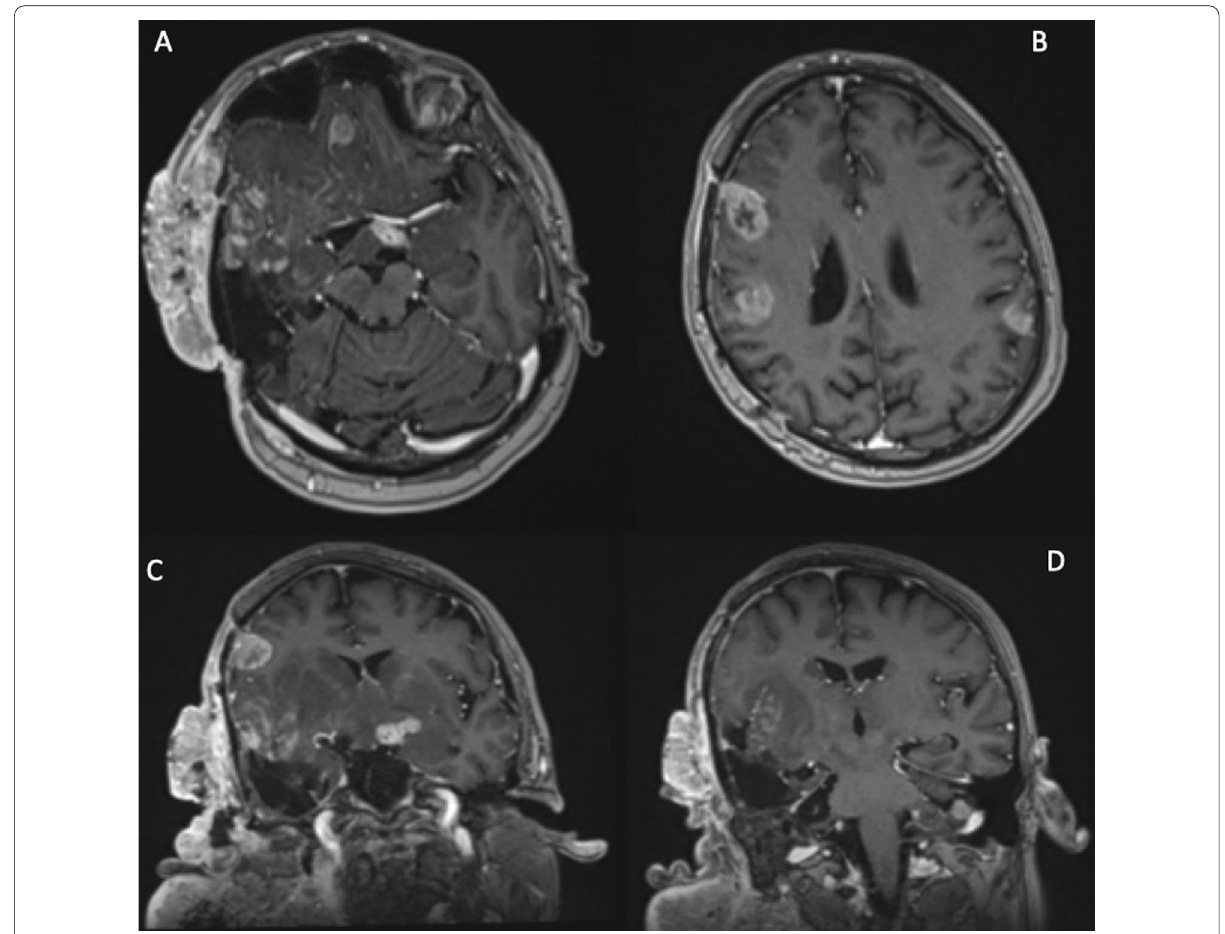
Fig. 7 Cranial MRI scan. A , B axial sections. C , D coronal